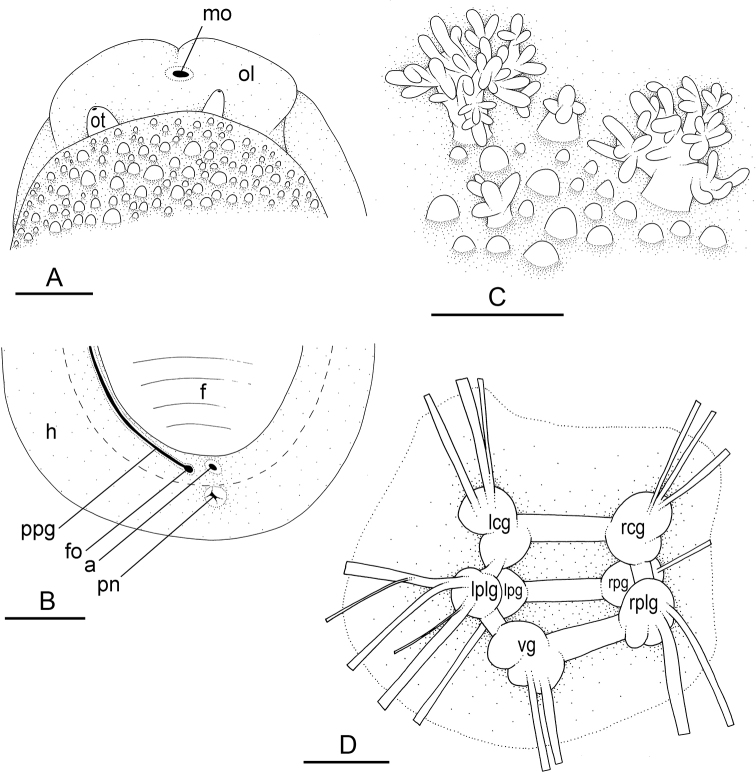
External morphology and nervous system, Peronia
verruculata (unit #1), Indonesia, Sulawesi [2127] (UMIZ 00170) A anterior, ventral view B posterior, ventral view, the dotted line shows where the foot normally expands (it was partly cut to illustrate the anus, the peripodial groove, and the female pore) C dorsal gills and papillae D nervous system, dorsal view. Scale bars: 5 mm (A, B), 2 mm (C), 1 mm (D). Abbreviations: a anus, f foot, fo female opening, h hyponotum, lcg left cerebral ganglion, lpg left pedal glanglion, lplg left pleural ganglion, mo male opening, ol oral lobe, ot ocular tentacle, pn pneumostome, ppg peripodial groove, rcg right cerebral ganglion, rpg right pedal glanglion, rplg right pleural ganglion, vg visceral ganglion.